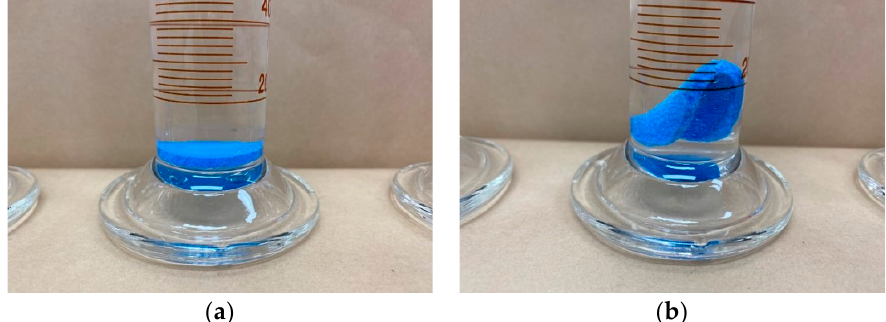
( c ) Figure 6. The specimen fabrication process: ( a ) stirring ; ( b ) coating ; ( c ) curing. ② Calculation of Swelling Rate The swelling rate test on the prepared specimen was conducted in accordance with the test method specified in a KS M 3736 Waterproofing sheet with expandable bentonite. The test was done by taking about 2 g of the sample, putting it in a graduated cylinder (100 mL), and filling 50 mL of distilled water up to the 50 mL scale mark of the graduated cylinder containing the sample by means of a burette. Then, the volume of the water re- maining in the burette is set as the initial volume (mL). After that, enough distilled water is added to the graduated cylinder to expand it for 120 h, and the distilled water is then removed to measure the volume after expansion in the same way as the initial volume measurement. The swelling rate is calculated using Equation (1), and the status is shown